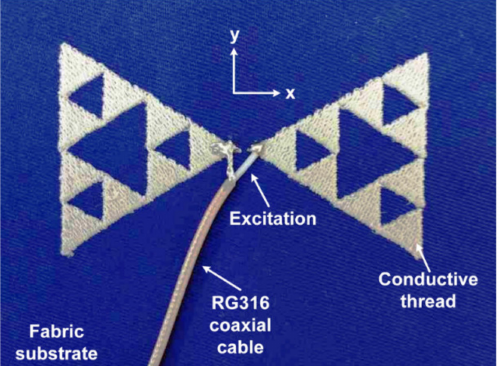
Figure 2. Picture of the bow-tie antenna prototype